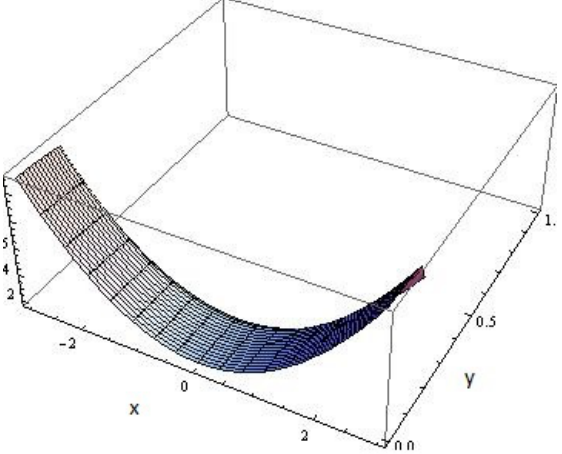
Figure 5. The local correlation component F θ T of the free energy fluctuations as a function of the vacuum parameter x : = θ and temperature y : = T , describing fluctuations of the YM vacuum ensemble for a given anomaly factor c , decoherence temperature d , and critical exponent e .